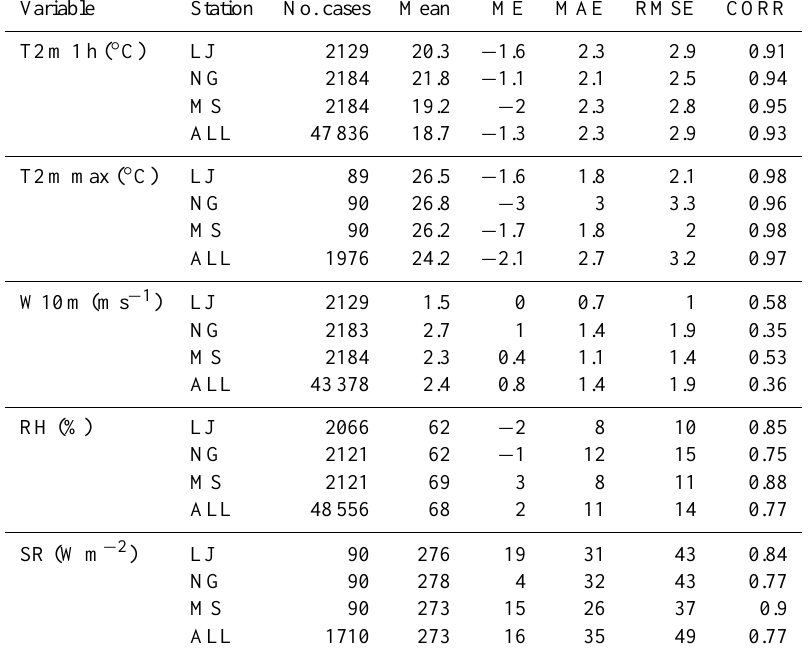
Table 2. Statistical scores for 1h values of 2m temperature (T2m), 10m wind speed (W10m), relative humidity (RH), and for daily average incoming solar radiation (SR). Shown are results for 1-day forecast, calculated separately for three measuring sites (LJ, NG, MS), and for 24 MET monitoring stations (ALL) during the 3-month period. In the case of temperature, results for daily maxima are also